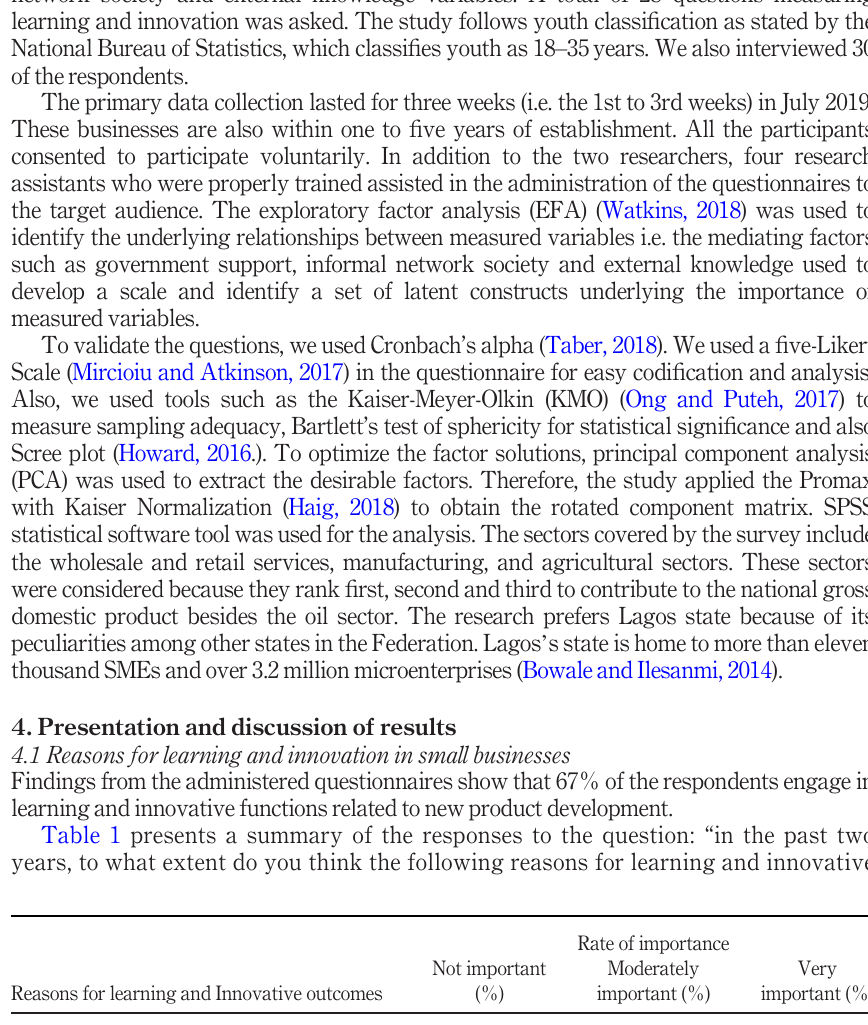
Table 1. Selected reasons for learning and innovations